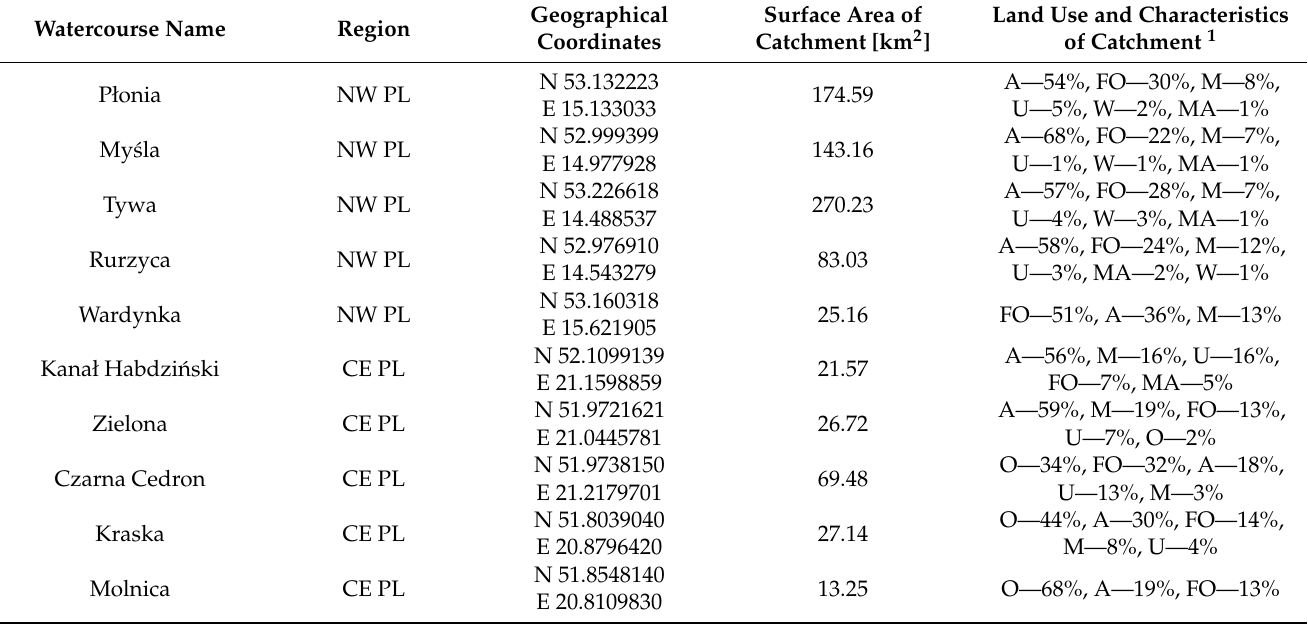
Table 1. Characteristics of sampling sites in the 10